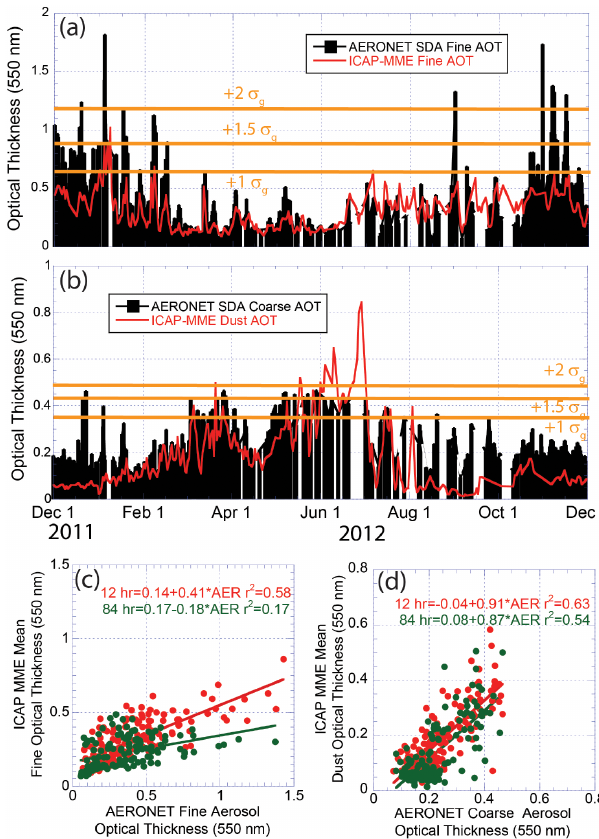
Figure 13. ICAP MME-AERONET comparisons for the Kanpur India site. Included are the (a) fine mode and (b) dust components. Marked are the 1, 1.5 and 2 geometric standard deviation lines. Also shown are scatterplots against 12 and 84h forecasts for (c) fine mode and (d) dust,